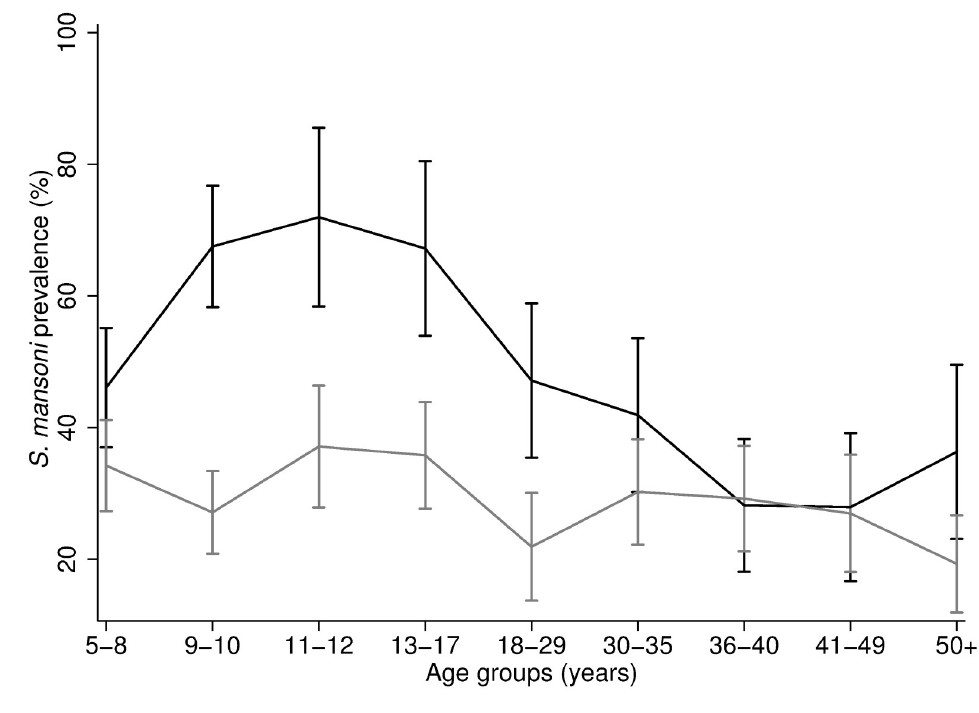
Fig 5. Interaction between age and distance from the village to Lake Victoria against infection status. The black line represents the infection prevalence across age groups for individuals located at a distance � 0.50km from Lake Victoria. The grey line represents the S . mansoni infection prevalence for individuals located at a distance � 0.50km from Lake Victoria. 95% confidence intervals are shown.